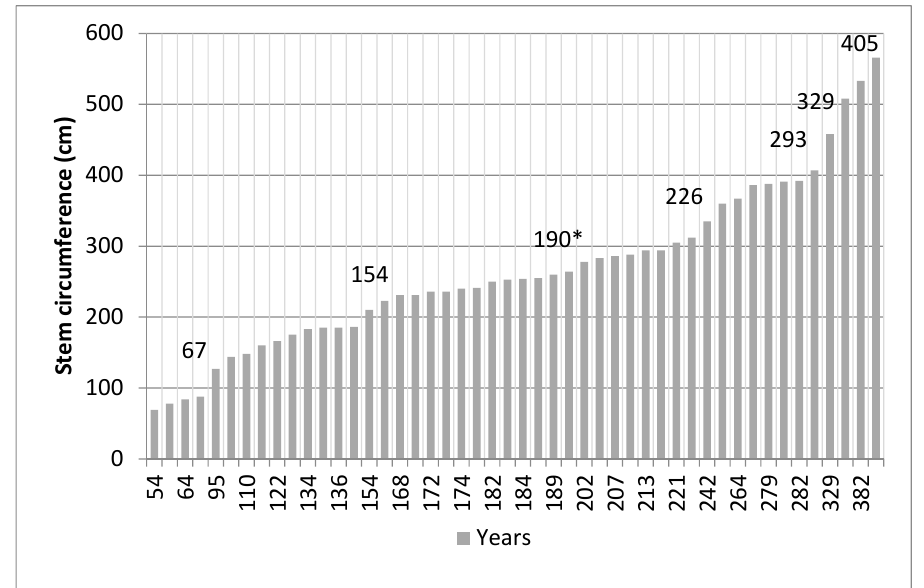
Figure 5. Tamarind tree age in Ankoba and Malaza. Note that exceptionally advantaged trees can attain ages between 300–400 years; whereas the usually accepted age is 200 years. 190* is the median age in Malaza of the central cohort (154–226 years).